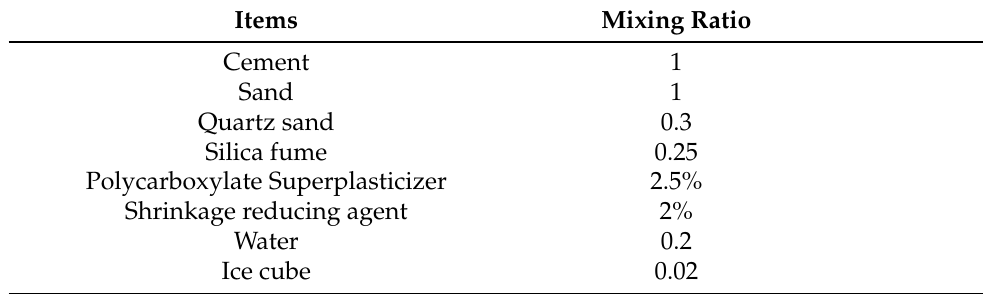
Table 1. Mixing ratios of main ingredients used in the production of the UHPC-PVA materials.